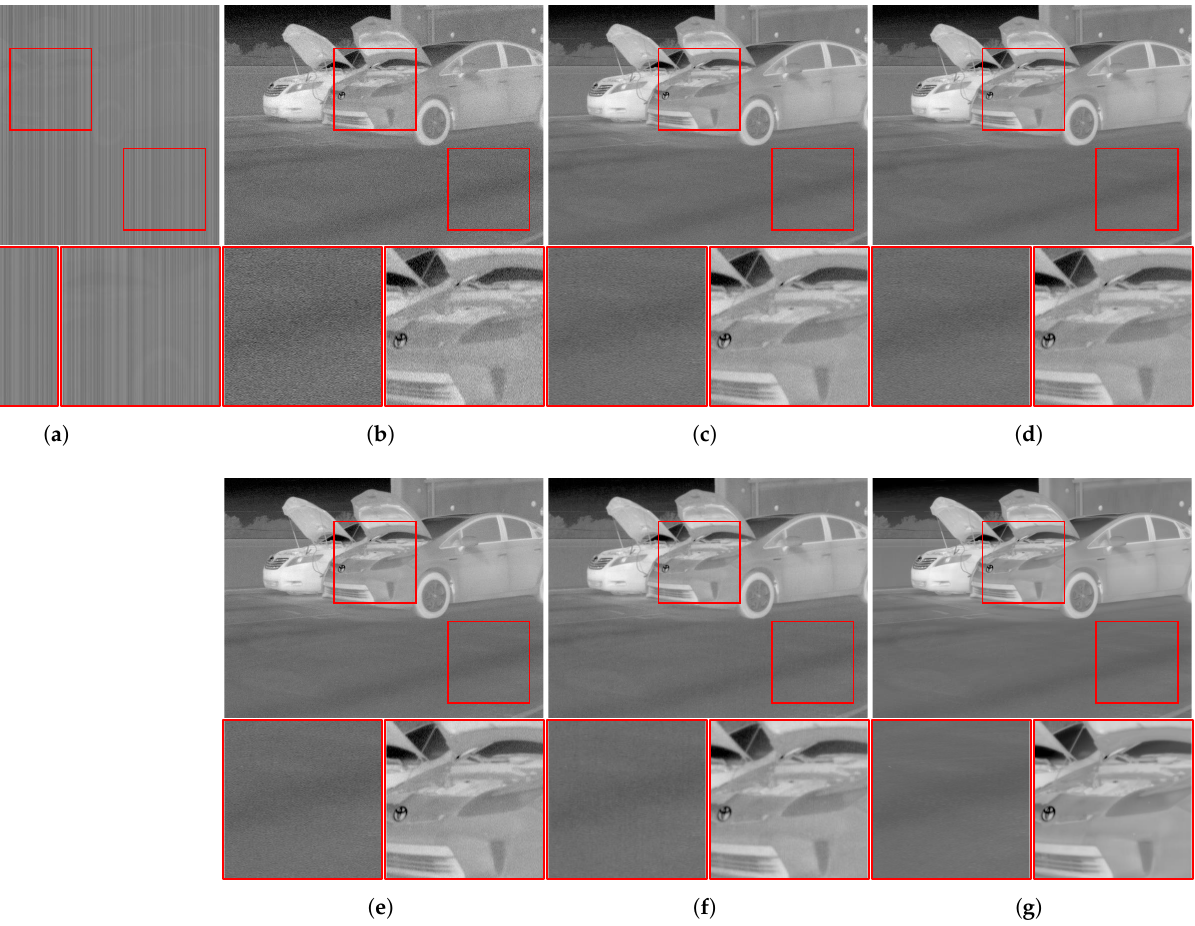
Figure 7. FPN-removed results of synthesized images restored by calibration-based FPN removal al- gorithms. ( a ) Degraded image; ( b ) two-point method [18]; ( c ) multi-point method [19]; ( d ) polynomial method [14]; ( e ) Proposed 1; ( f ) Proposed 2; ( g ) original